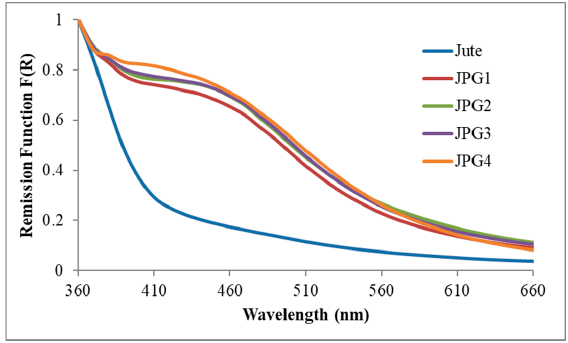
Figure 9. Normalized GSDR spectra of the jute fabric with Ag NPs-PEG obtained using different AgNO 3 concentrations.